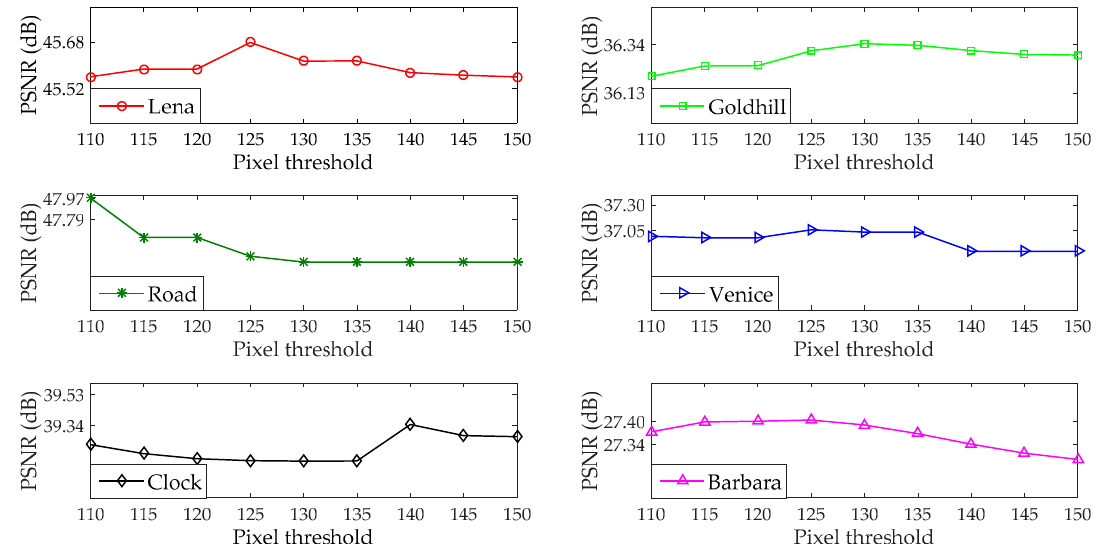
Figure 15. Relationships of pixel threshold to the PSNR value in different experiments.